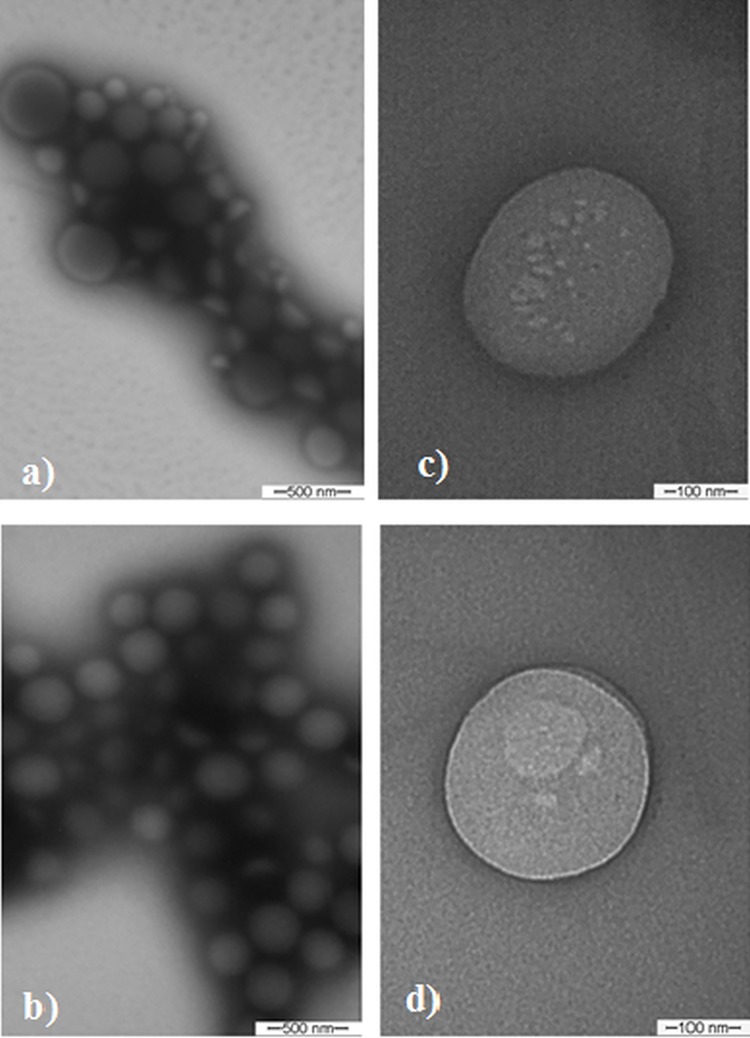
Micrographs obtained through transmission electron microscopy.(a-b) SLN and 15d-PGJ2-SLN at 77.500x magnification; (c-d) SLN and 15d-PGJ2-SLN at magnification 215.000x magnification. The bars indicate image scales.